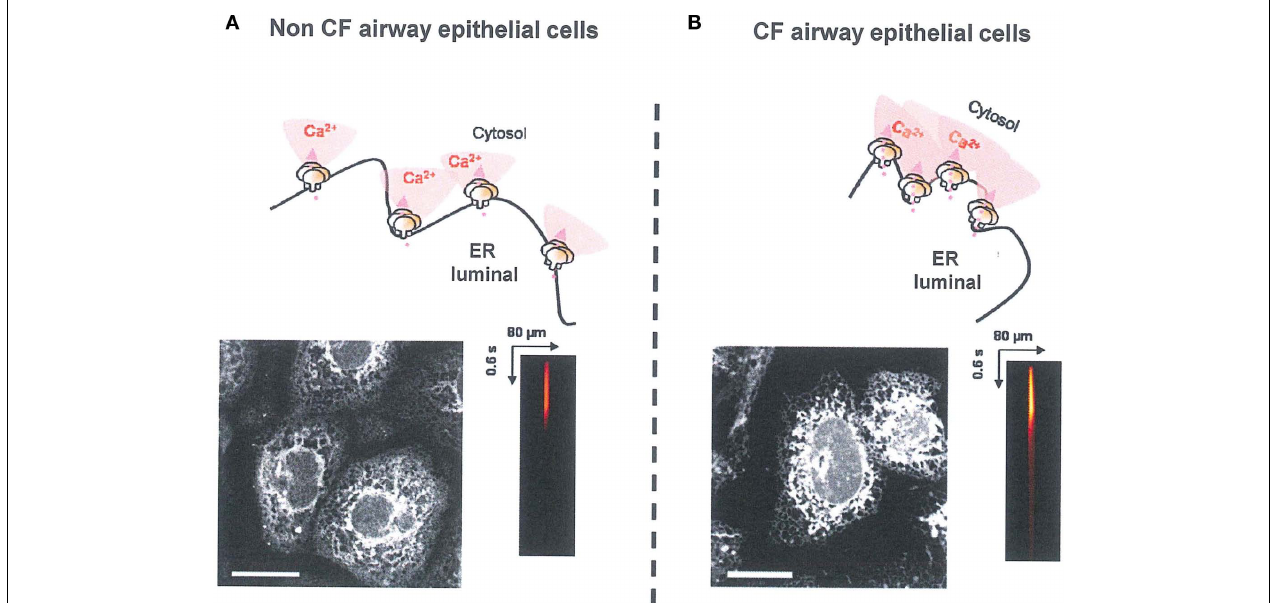
ER.The ER was concentrated around the nucleus. IP3Rs are more clustered and the Ca 2 + propagation wave was abnormally increased. ER staining was